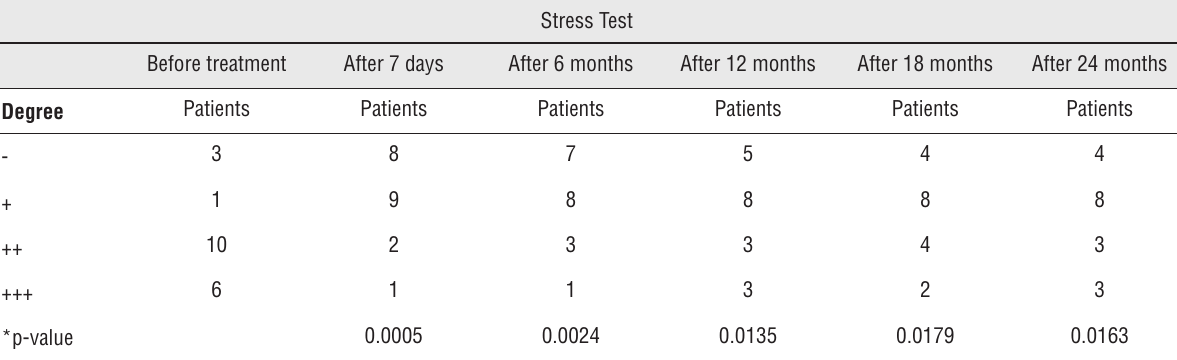
Table 3 - Degree of urinary incontinence assessed by stress test before and after treatment with